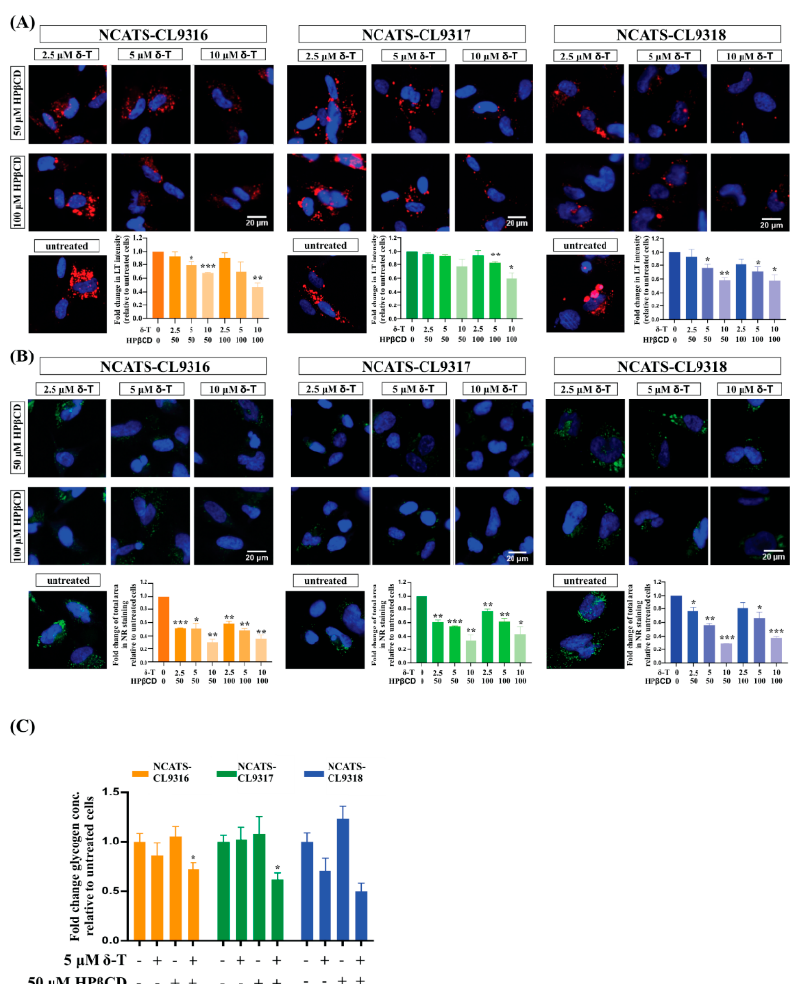
Figure 4. Therapeutic effects of the δ -tocopherol and HP β CD combination in Pompe disease NSCs. ( A ) Representative images of LysoTracker (LT) staining (red) of combination treated NSCs. Bar graph presents the quantitation of LysoTracker staining after the combination treatment. Error bars represent SEM of three independent experiments (* p < 0.05, ** p < 0.01, and *** p < 0. 001 by t -test). ( B ) Representative images of Nile red (NR) staining (green) of combination treated NSCs. Bar graph presents the quantitation of Nile red staining after combination treatment. Error bars represent SEM of three independent experiments (* p < 0.05, ** p < 0.01, and *** p < 0.001 by t -test). ( C ) Changes of total amount of cellular glycogen in NSCs after treated with δ -tocopherol ( δ -T), HP β CD and their combination. Error bars represent SEM of three independent experiments (* p < 0.05 by t